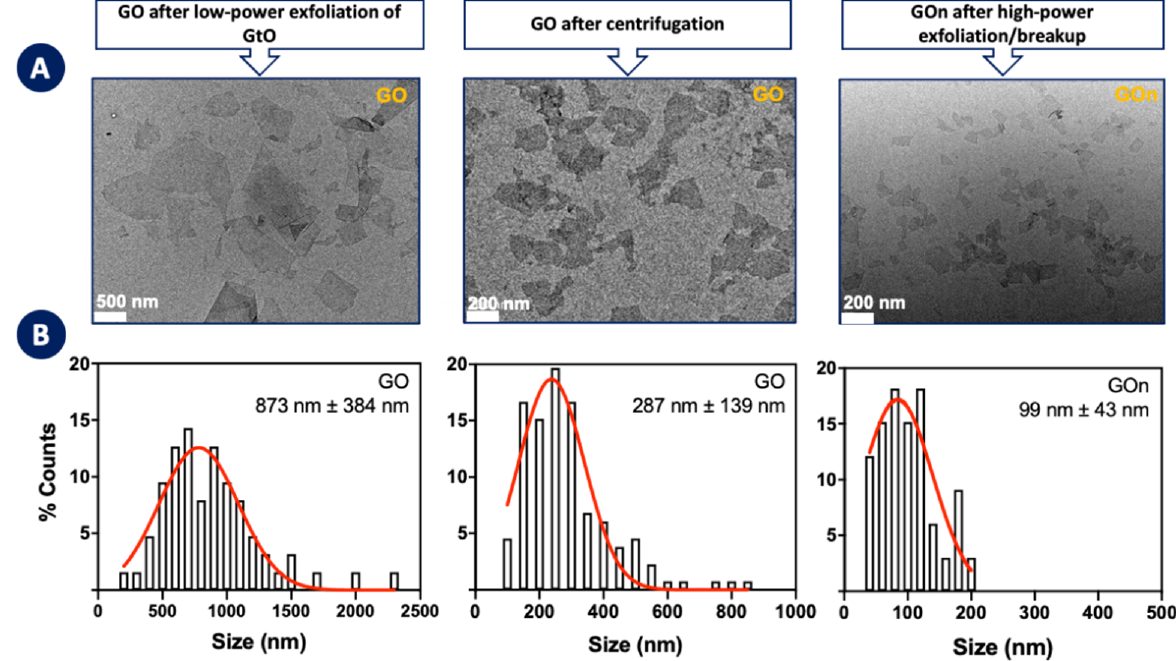
Figure 3. Morphology of GO and GOn. ( A ) Representative TEM images of GO and GOn aqueous dispersions and ( B ) respective particle size distributions and average sizes and standard deviations, as determined from TEM